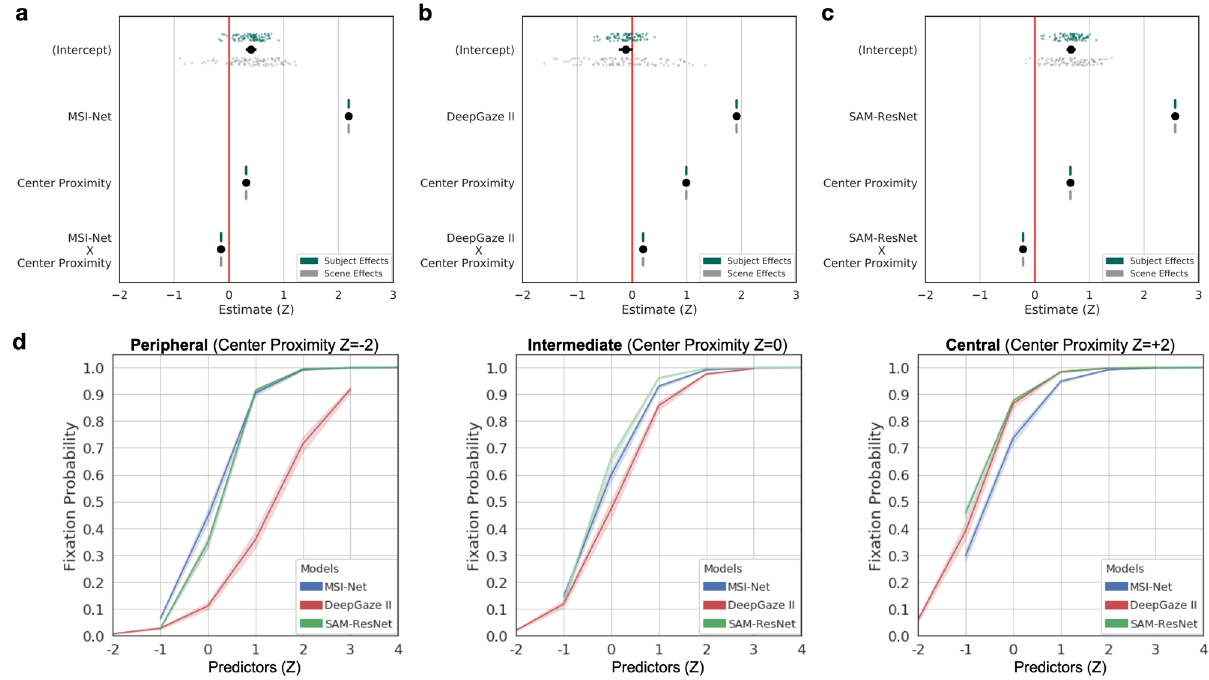
Figure 2. Deep saliency model general linear mixed effects model results. Whether a scene region was fixated or not was modeled as a function of the mean deep saliency model value, mean center proximity value, and their interaction as fixed effects ( a MSI-Net; b DeepGaze II; c SAM-ResNet). The black dots with lines show the fixed effect estimates and their 95% confidence intervals. Subject (green dots) and scene (grey dots) were both accounted for in the model as random intercepts. ( d ) A line plot of the interaction between center proximity (panels) and each deep saliency model (colored lines) as a function of fixation probability. All error bands reflect 95% confidence intervals.